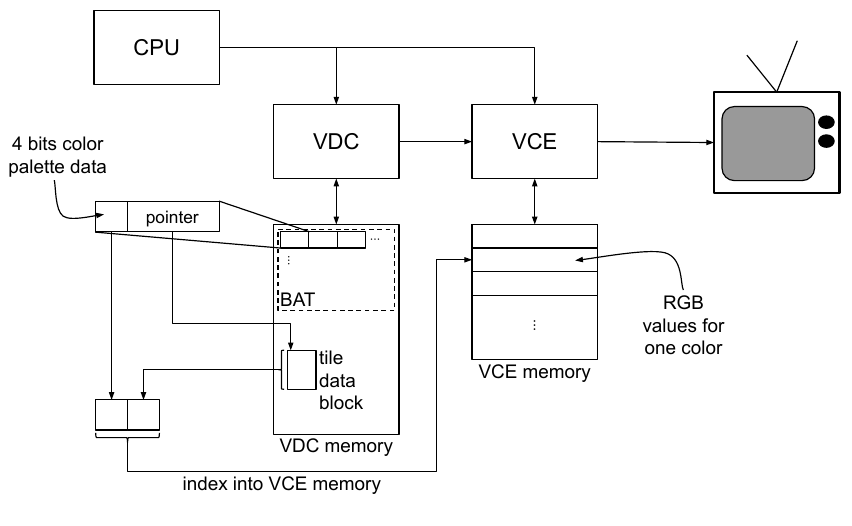
Figure 1. Overview of PC Engine graphics architecture and data